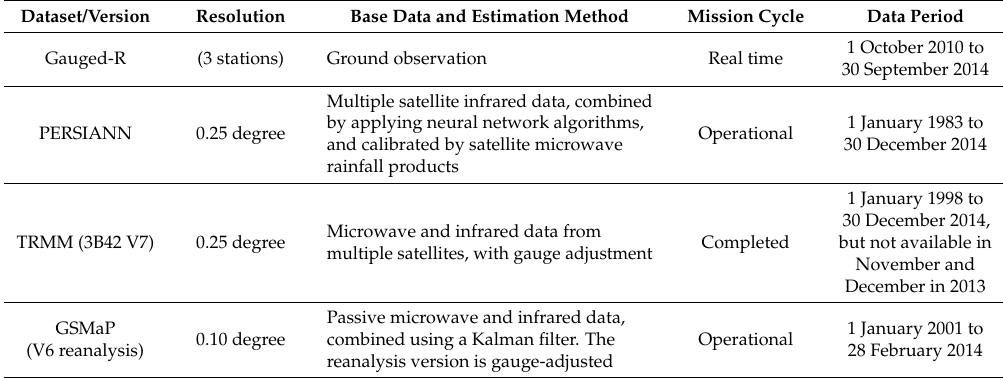
Table 1. Satellite rainfall estimates data description and its salient